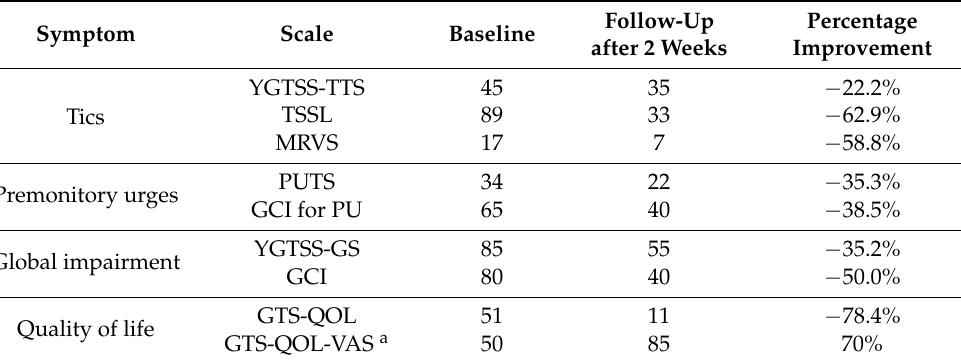
Table 1. Clinical measurements before and after treatment with nabiximols.